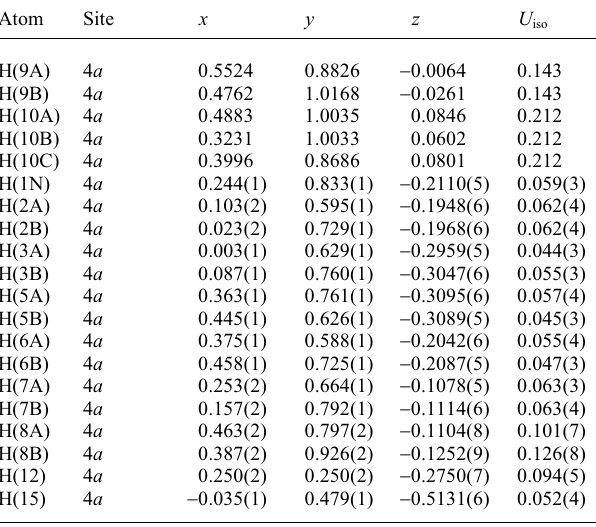
Table 2. Atomic coordinates and displacement parameters (in Å 2 )